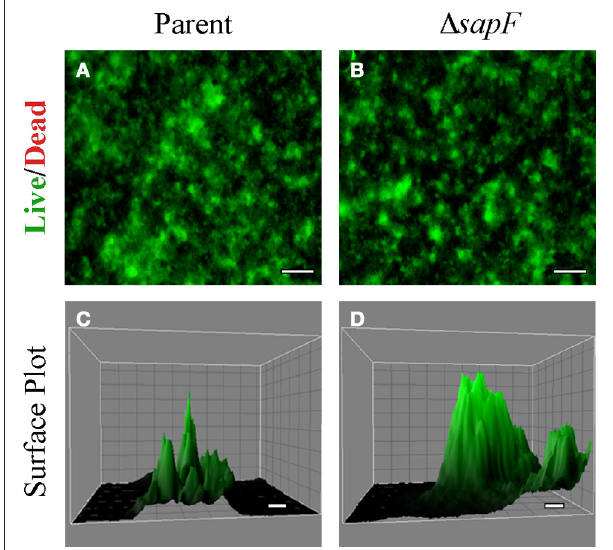
FIGURE 4 | Biofilm density and architecture in the absence of SapF. The parental strain (A, C) or the SapF-deficient strain (B, D) were grown in DIS medium without heme on a glass chamber slide for 48h. Biofilm structure was assessed by fluorescence microscopy following staining with the Live/Dead viability stain (see “Materials and Methods”). The surface area of a representative portion of the biofilm was generated from a series of optical sections using ImageJ software for the parental strain (C) , and the SapF-deficient strain (D) . Scale bar = 100 μ m (A, B) or 10 μ m (C, D) .